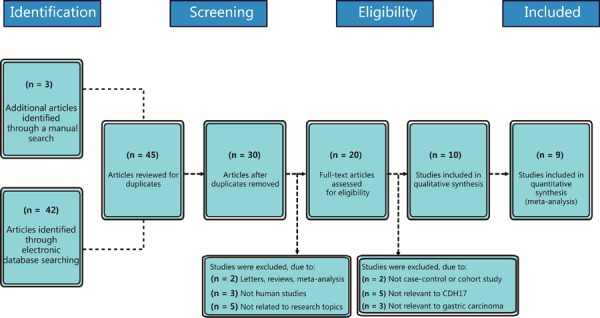
Flow chart showing the detailed study inclusion and exclusion procedures.
Nine cohort studies were included in this meta-analysis.